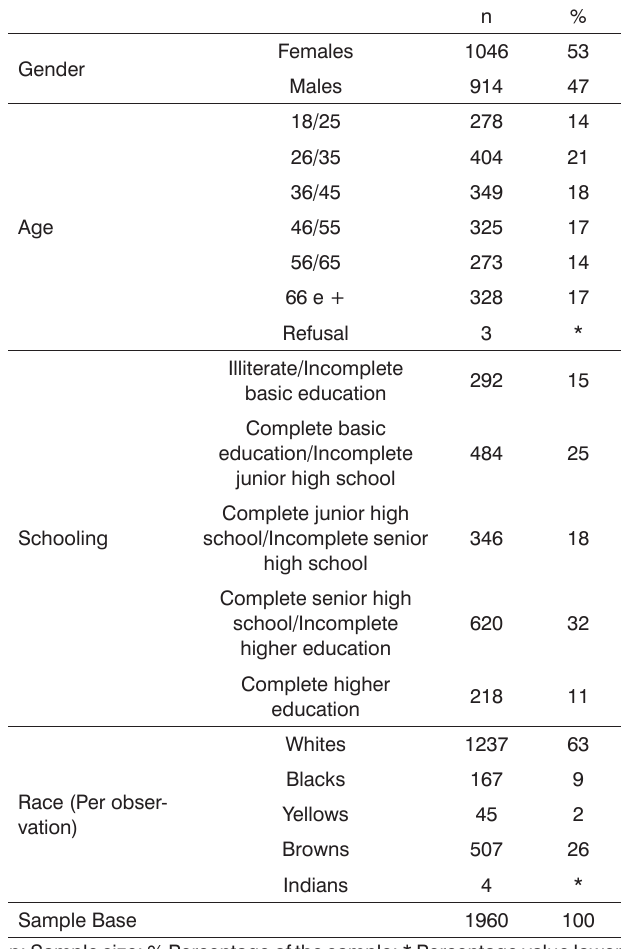
Table 2. Descriptive analysis of the profile of the sample col- lected for the city of São